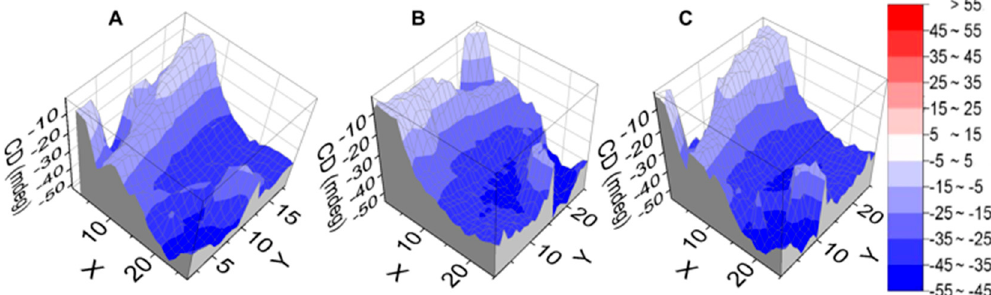
Figure 3. Three-dimensional ECD maps of film of 1 from DMF at 391 nm: ( A ) top; ( B ) bottom; ( C ) bottom flipped along the y -axis, indicating good degree of homogeneity and lack of linear dichroism and linear birefringence (LDLB) contributions; the steps for x - and y -axes are represented every 0.2 mm.